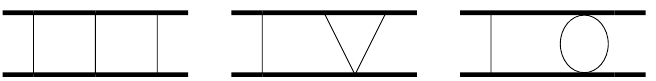
Figure 4 . Master integral topologies related to iteration of radial action or EFT potential, re- sponsible for classically divergent terms in the amplitude. The IX diagram corresponding to the second one in figure 2 does not appear since it is not divergent in the potential region, so receives no subtraction in a conservative calculation. The subtraction in the soft region is designed to be identical to the subtraction in the potential region — this works as long as we restrict to the real part where the only divergences comes from A 3 tree